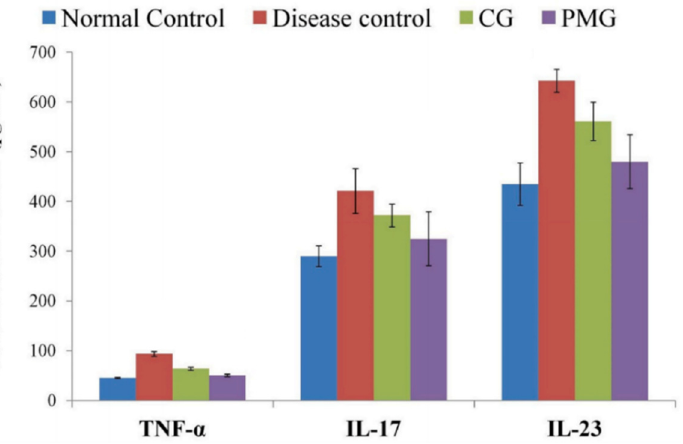
Figure 9. Serum cytokines concentration (TNF- α , IL-17, and IL-23) of different groups. Reprinted with permission from [23]. Copyright Elsevier